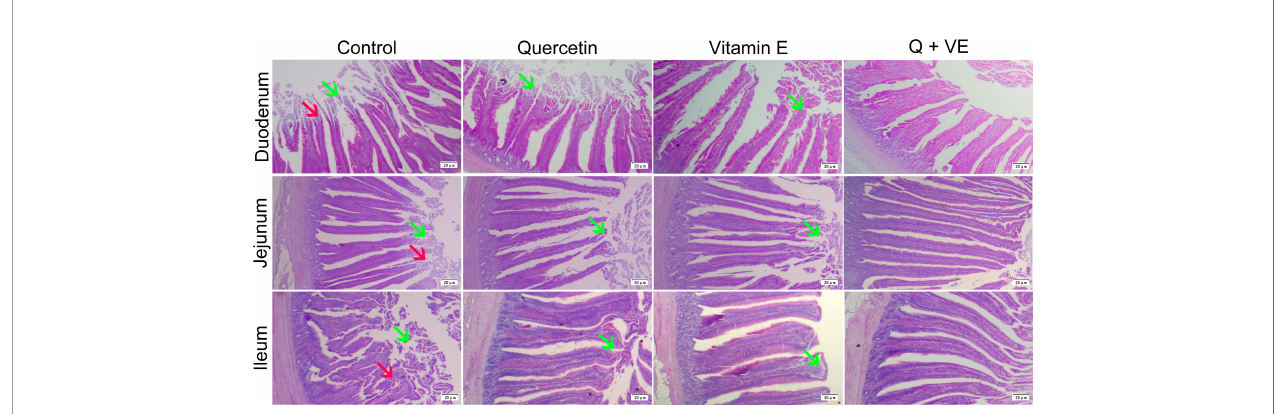
FIGURE 6 | Effect of Q, VE, and Q + VE on intestinal in fl ammation in aged breeder hens. (Control, Q, and VE) Effects of dietary Q, VE, and Q + VE on intestinal histology in the Control group; quercetin group; vitamin E group; and Q +